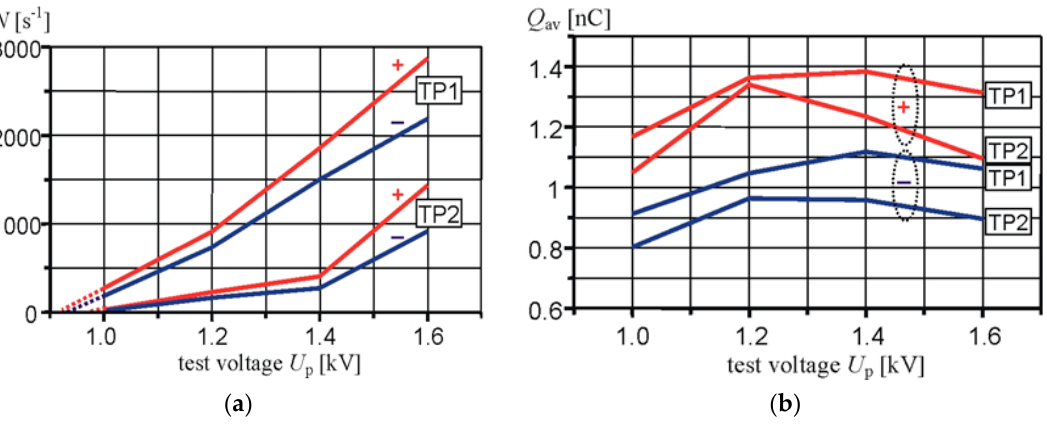
Figure 24. Calculated PD parameters: ( a ) pulse number per second N ; ( b ) the average apparent charge Q av vs. test voltage (both polarities of PD pulses registered for samples TP1 and TP2).